Question: Sum up the contents of this chart in one sentence.
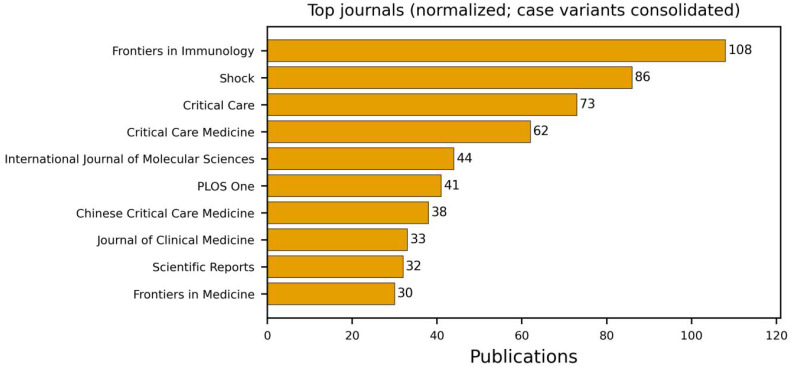
Answer: Top journals by publication output in host response-oriented sepsis research. Journals were ranked according to the number of publications in the strictly deduplicated dataset. The distribution shows that this field is mainly disseminated through journals related to immunology, critical care medicine, infectious diseases, and translational biomedical research.